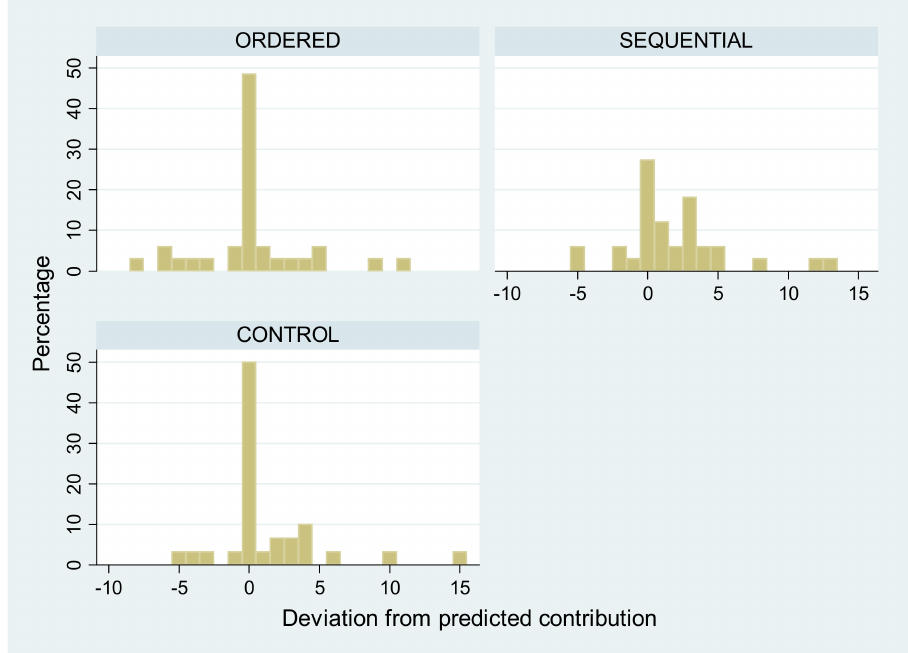
Figure 1. Percentage of choices that deviate from the predicted contribution in the one-shot